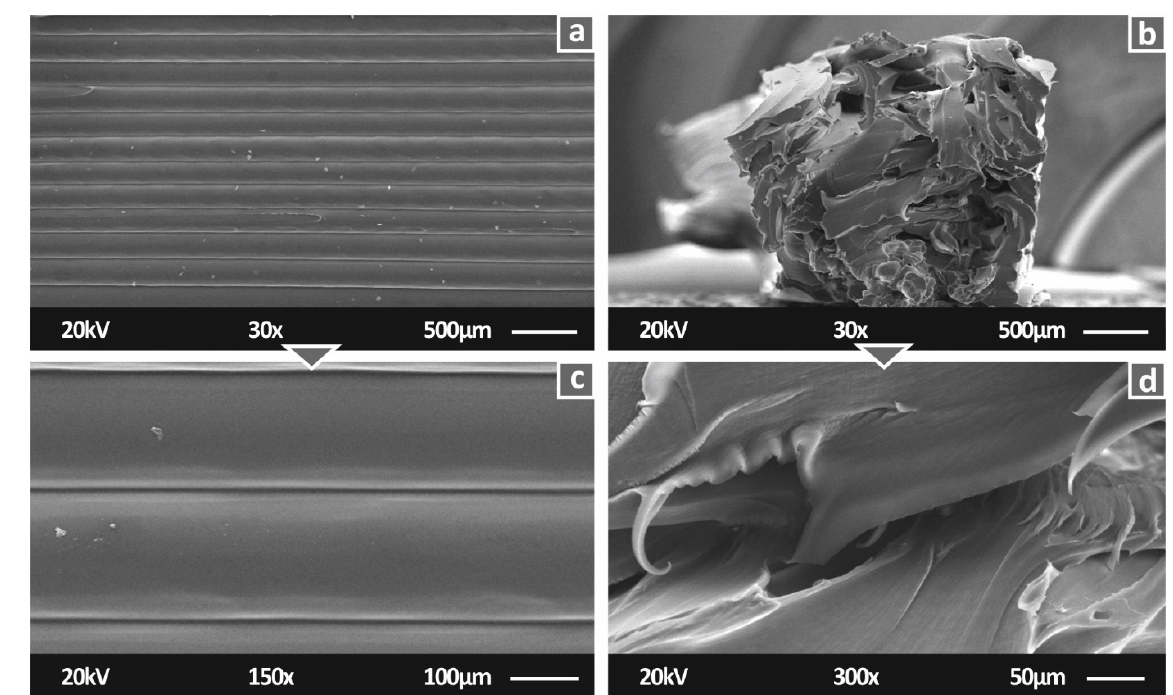
Figure 7. Pure PA12 SEM images: ( a ) 30× magnification on side surface; ( b ) 30x magnification on fracture area; ( c ) 150× magnification of side surface; ( d ) 150× magnification on fracture area.